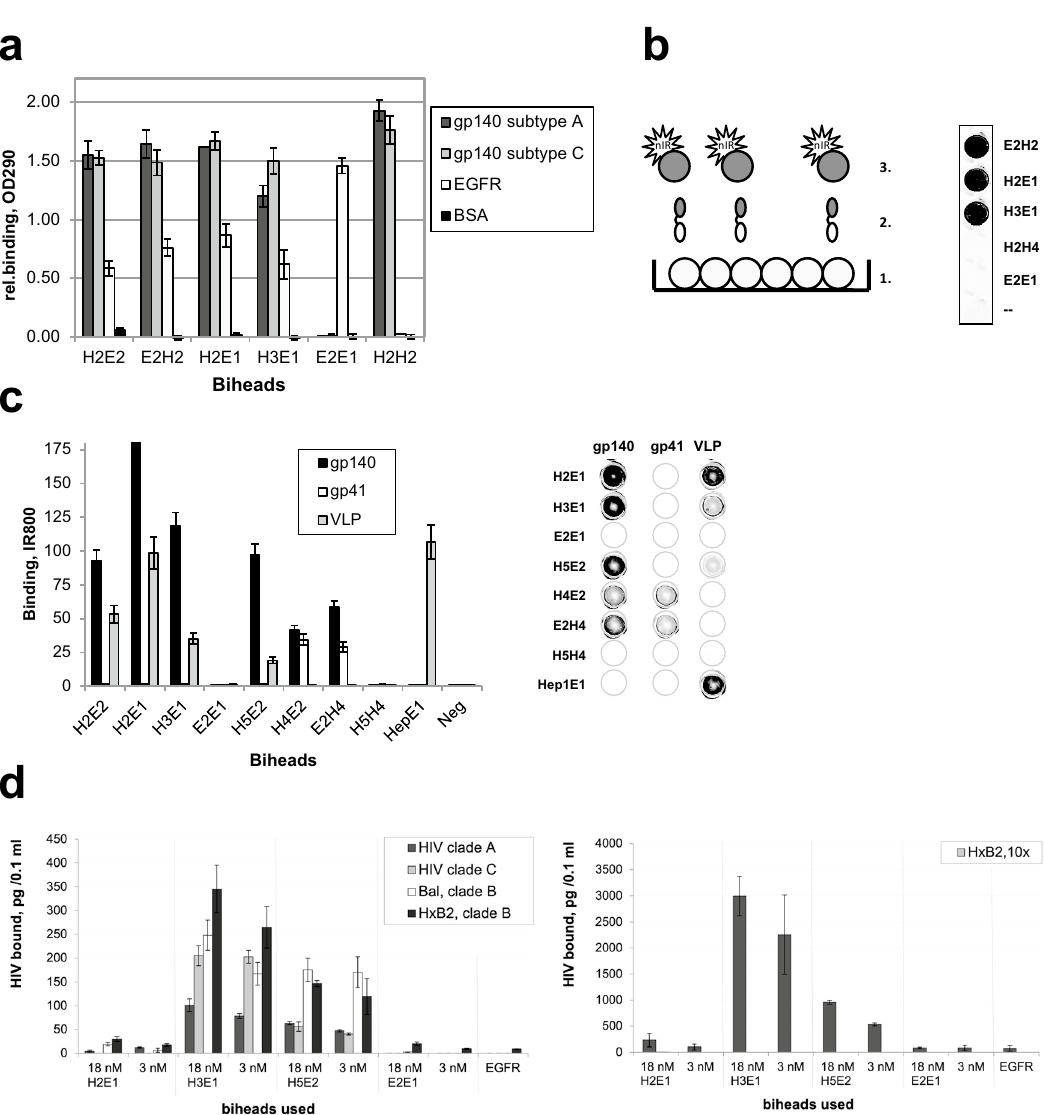
Figure 1. Bispecific VHH llama antibodies target HIV to EGFR ectodomain. ( a ) The VHHs in bispecific constructs retain good binding properties. Wells were coated with antigen, binding measured by ELISA. n = 2, representative experiment shown. ( b ) Bispecific VHHs mediate binding of HIV- antigens to EGFR ectodomain. Schematic set-up [with 1 = immobilised EGFR in wells, 2 = (heterospecific) bihead VHHs and 3 = IR800 labeled HIV-1 protein] and IR800-labeled gp140 UG membrane protein specifically targeted to EGFR in wells. n > 2, representative experiment shown. ( c ) Overview of relative efficacies of targeting by bispecific VHHs. gp140 is gp140(UG37), Virus like particle (VLP) is VLP HIV, except for Hep1E1 it is VLP HBV. Shown are quantitative IR800 FLISA results and for overview an IR800 scan of a representative microtiter plate (dotted circles mark the wells) is shown. n = 2. ( d ) Efficient targeting of low and high concentration HIV-1 to the coated EGFR ectodomain. Viruses were pre-incubated with 18 nM or 3 nM biheads for 1 h and bound to EGFR coated ELISA plate for 2 h. Bound HIV was detected by a p24 ELISA. Left graph Viral concentration in the input was 10.1, 4.9, 3.9 and 9.0 ng/100 µl for clade A (92UG037), clade C (96ZM651), and clade B reference strains Bal and HXB2, respectively. Right graph The same with 10 times concentrated HXB2. Clade b, n = 2, mean ± sd; Clade A and C, n = 1, duplo